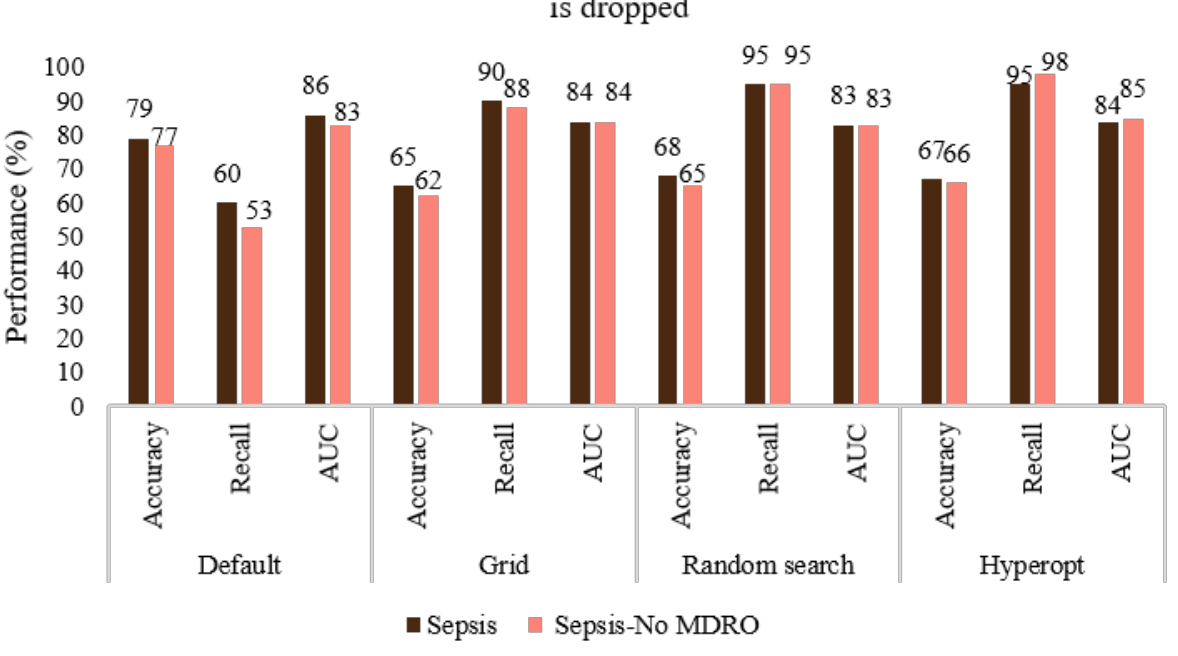
Figure 8. Comparing the performance of the default, grid search, random search, and Bayesian optimization (hyperopt) models when the predictive variable MDRO is removed from the feature set to predict sepsis.